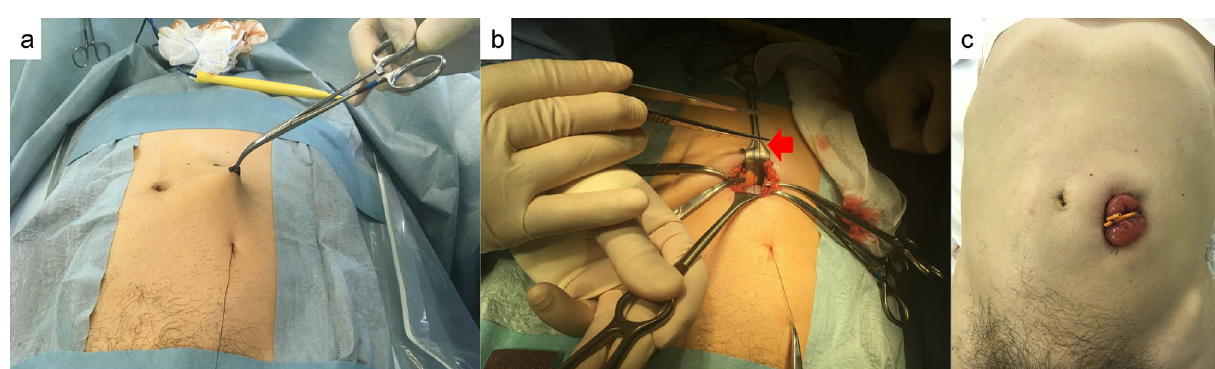
Figure 4. Creation of the colostomy. ( a ) The nylon thread is pulled out of the body, and a circular skin incision is performed at the site previously marked for stoma position. ( b ) The nylon thread in the abdominal cavity is identified through the site of puncture (red arrow). ( c ) The sigmoid loop colostomy is created without